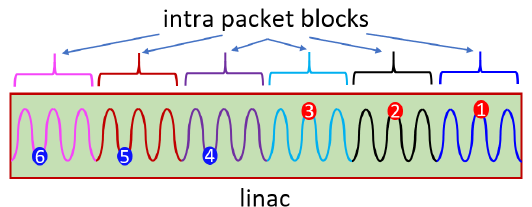
FIG. 2. Bunch packets in the ERL. Bunches at the third turn go through a transition arc where there is at least an extra half rf cycle